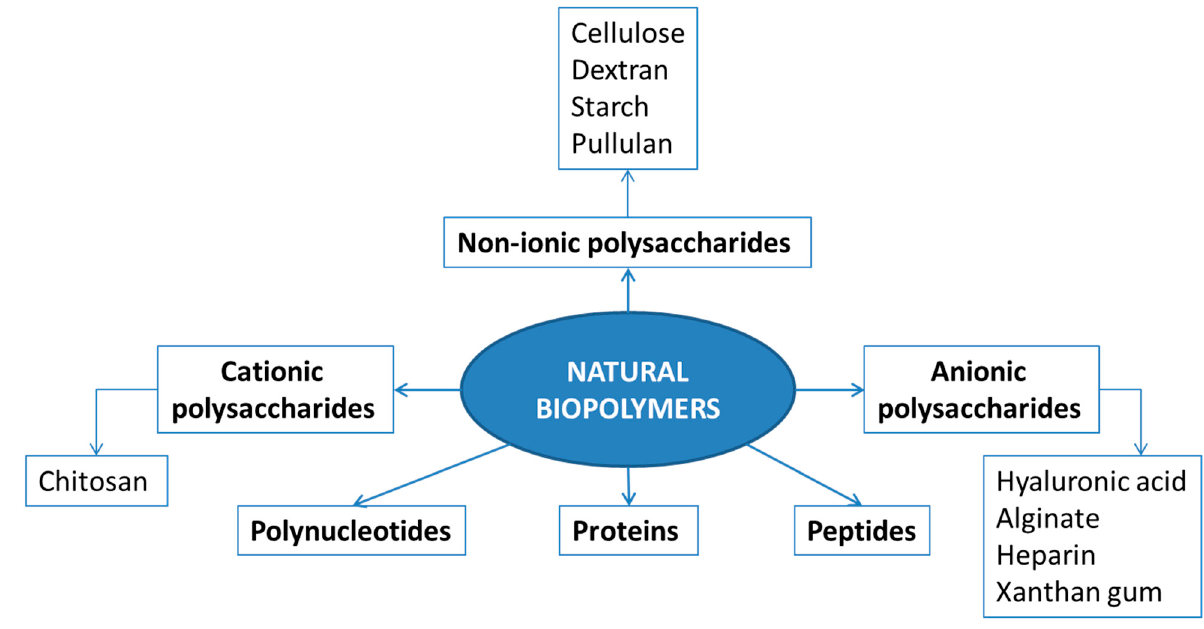
Figure 1. Different types of natural biopolymers.